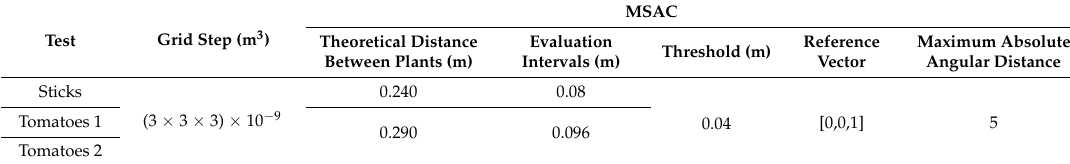
Table 4. Aerial point cloud extraction parameters